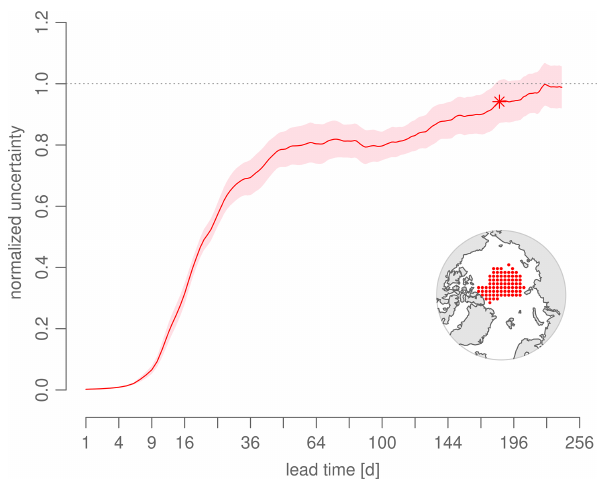
Figure B3. Additional simulation for AWI-CM1 with longer lead times. The time series shows the normalized uncertainty for the ini- tial positions on the inset map. The asterisk marks the lead time when the climatological saturation value is attained for the first time (one-sided t test, 0 . 95 level): there is no infinite predictability from the Lagrangian perspective. Note the square root horizontal axis.